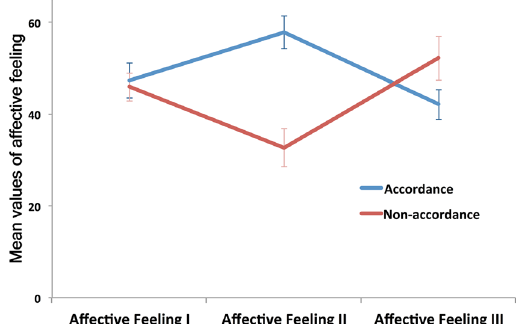
Figure 3. Contrasting changes in affective feelings underline the distinct attitude to be in accordance or non- accordance with others. To control for the effect of material vantage on the affective feeling, we focused on the cases in which a participant’s income was higher than their partners’ income. We distinguished two cases with changes in the affective rating that were unexpected and expected from the material vantage. Based on the comparison of the contrasting pattern, i.e., going up (down) and up (down), in the ratings of Affective Feelings I, II, and III, we regarded the participants as preferring accordance and non - accordance with others, respectively. The transformation of the affective change reveals a significant difference for the accordance and non - accordance attitudes. Before playing the game, their ratings (Affective Feeling I) were not significantly different ( p = 0.783, two-tailed t -test; 47.3 ± 3.8 and 45.9 ± 3.1), but after playing, their ratings (Affective